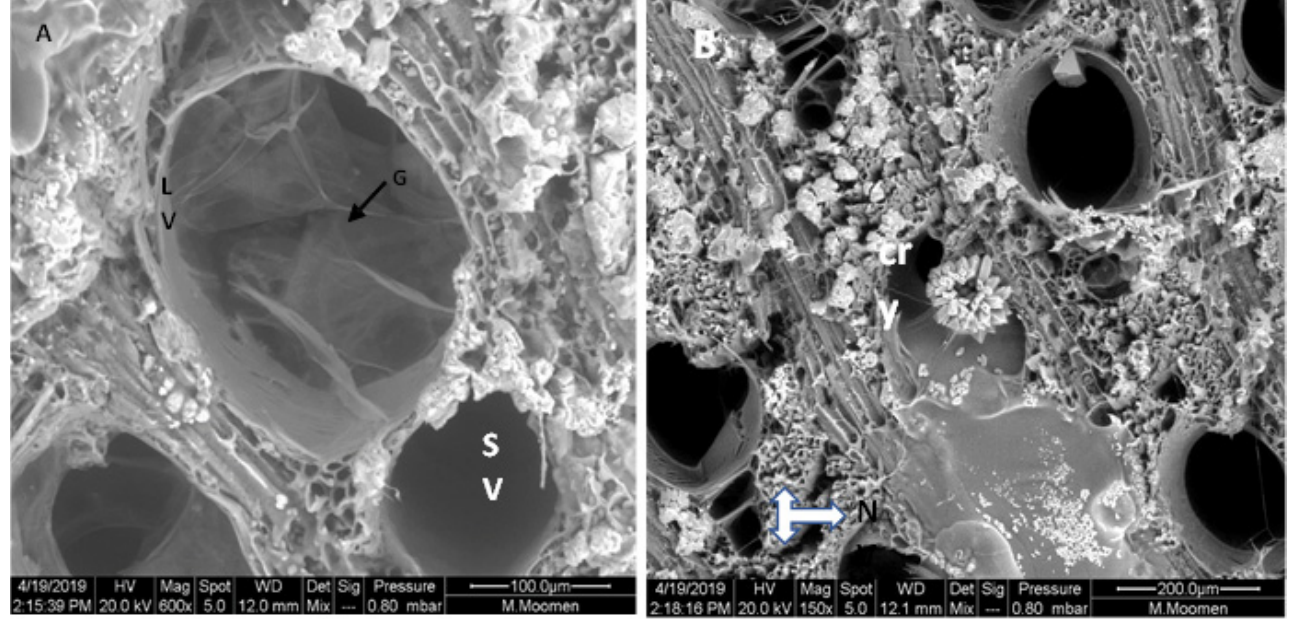
Figure 6. ESEM micrographs of Razegui2 stem cross section revealing in ( A ): an occluded lumen with gel (G) of the large- (LV). and a clear lumen of the small diameter vessels (SV). Note that vessels were surrounded by several crystal units ( B ): in Razegui1, a serial of narrower vessels (NV) do not display any occlusion form in the lumen tissue. Note the presence of crystal units (cry). Gum occlusions were also found in xylem vessel elements, obstructing entirely sev- eral vessels (Figure 7a). Diffuse and condensed gum deposits were also identified on Khamri and Hencha cross sections (Figure 7b,c).